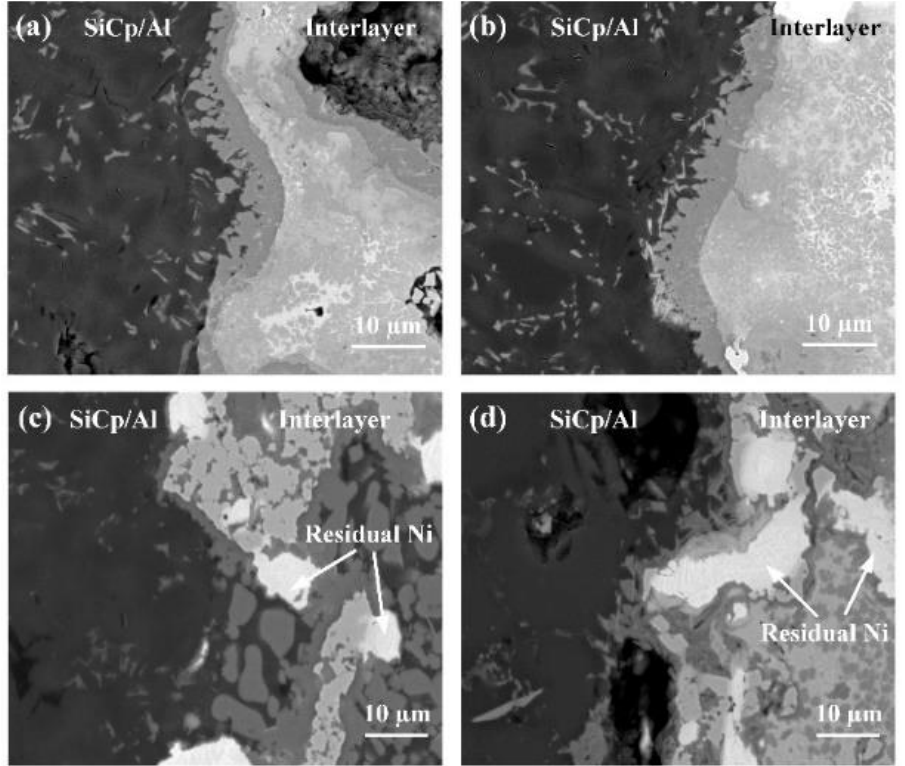
Figure 10. Interfacial bonding characteristics of the joints bonded with different interlayers. ( a ) Zr 5 wt.%; ( b ) 8 wt.%; ( c ) 15 wt.%; ( d ) 20 wt.%. ( a ) Zr 5 wt.%; ( b ) 8 wt.%; ( c ) 15 wt.%; ( d ) 20